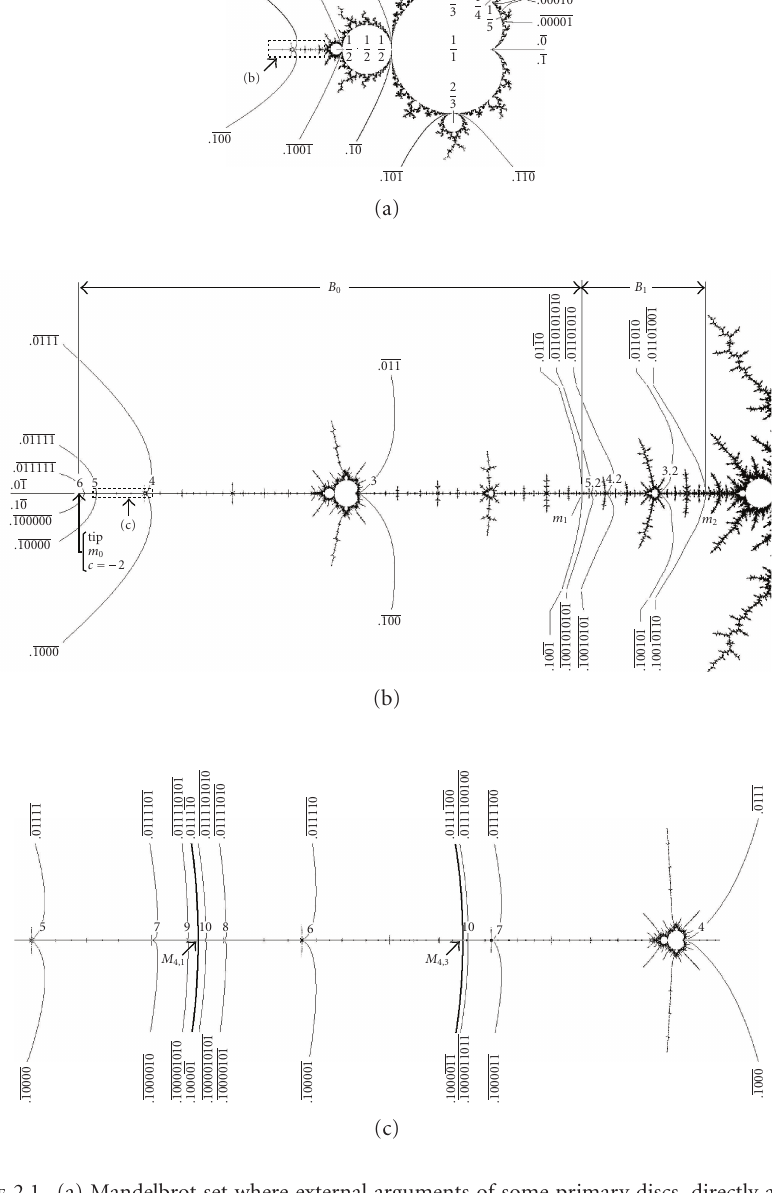
Figure 2.1 . (a) Mandelbrot set where external arguments of some primary discs, directly attached to the main cardioid, and structural components in the real axis are shown. (b) Magnification of the antenna, marked with a rectangle in (a). (c) Magnification of a detail of the antenna, marked with a rectangle in